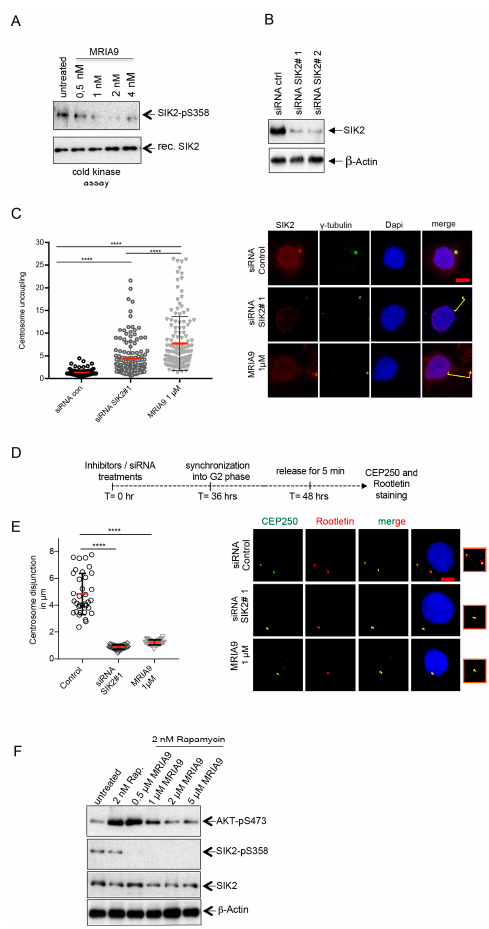
Figure 1. MRIA9 potently inhibits SIK2 and prevents the centrosome disjunction during the late G2 phase. ( A ) Recombinant GST-SIK2 was subjected to a cold kinase assay in the presence of increasing concentrations of MRIA9 (0.5 to 4 nM). The reaction was immunoblotted for SIK2-pS385 to monitor the autophosphorylation and for SIK2 using specific antibodies. ( B ) SKOV-3 cells were treated for 48 h with two siRNA against SIK2. Cell lysates were analyzed by immunoblotting for SIK2 and β -Actin. ( C ) MRIA9 causes nuclear centrosome uncoupling (NCU). SKOV-3 cells were treated with siRNA SIK2#1 and 1 µ M MRIA9 for 48 h. Cells were fixed and processed for immunofluorescence using gamma-tubulin, SIK2, and DAPI. ( left ) The centrosome nuclear distances were measured in µ m and plotted as a scatter plot with mean ± SD. Values were calculated from at least 100 cells per treatment and statistically analyzed (**** p < 0.001). ( Right ) Representative figures of NCU in the different treatment groups. The yellow lines indicate the centrosome nuclear distance in µ m. Scale bar = 10 µ m. ( D ) Scheme of the experimental procedure. SKOV-3 cells were treated with siRNA SIK2#1 and 1 µ M MRIA9 and synchronized into the G2 phase. Cells were shortly released into mitosis, then fixed and processed for immunofluorescence using CEP250, Rootletin, and DAPI. ( E ) MRIA9-induced inhibition of SIK2 results in centrosome disjunction failure. ( Left ) The centrosome separation in the different treatments was assessed by measuring the distance in µ m between the separated CEP250 and Rootletin signals. The values were represented as a scatter plot. Values were calculated from at least 35 cells per treatment and statistically analyzed (**** p < 0.001). ( Right ) Representative figures of centrosome disjunction failures in the different treatment groups. Insets: Magnifications showing the centrosome disjunction in the different treatment groups. Scale bar = 10 µ m. ( F ) SKOV-3 cells were first treated with 2 nM rapamycin for 16 h and subsequently treated with increasing concentration of MRIA9 (0.5 to 5 µ M) up to 48 hrs. Cells were lysed and immunoblotted for AKT-pS473, SIK2-p378, SIK2, and β -Actin using specific